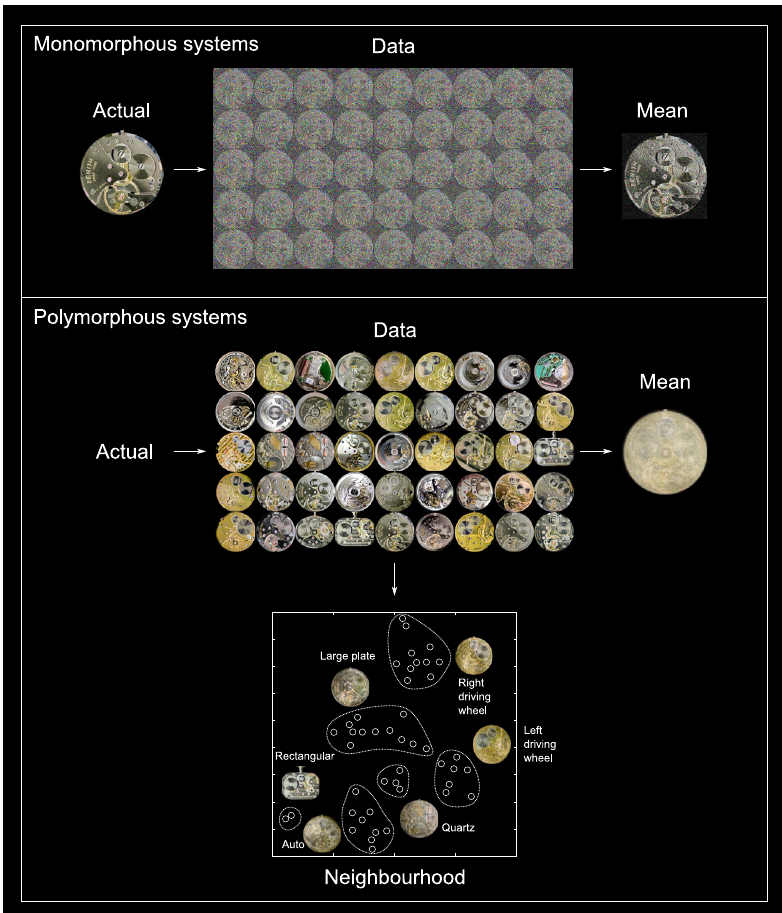
Figure 3. Monomorphous vs polymorphous systems. Where the fundamental architecture of a biological system is the same, our best guide will be the simple mean of the population, for each individual will differ from it randomly. Studying such monorphous systems is illustrated by adding random noise to an image of a specific watch mechanism, and then averaging across 45 noisy instances. The underlying architecture is thereby easily revealed. Where the solution in each individual differs locally, illustrated by taking a family of 45 different watch mechanisms of the same brand, the population mean is a very poor guide, for individual variability is no longer noise but the outcome of a plurality of comparably good solutions. We must instead define local regularities of organisation, here done by t stochastic neighbour embedding of the images into a two dimensional latent space, revealing characteristic features of each family of solutions. Given that neural systems are complex, stochastically initiated, and optimised by feedback, polymorphous architectures are likely to dominate, mandating a data-driven, neighbourhood-defining approach to